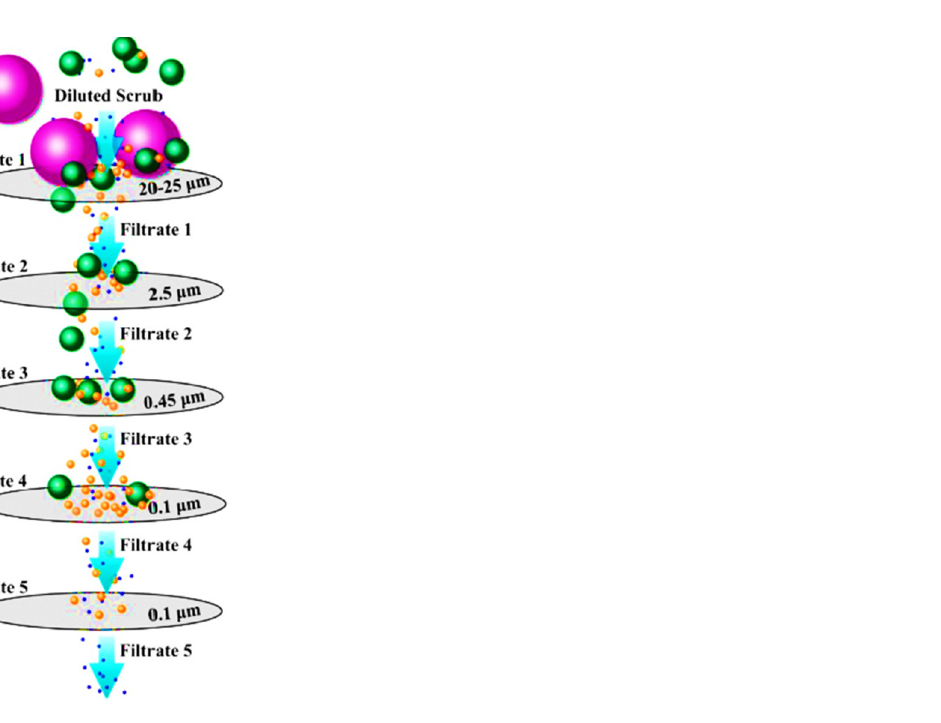
Figure 2. A flow diagram of the progressive filtering method used to remove PE NPs from commercial face scrubs. Ref [15] Reproduced with permission from Hernandez, et al., Environ. Sci. Technol. Lett., published by American Chemical Society, 2017.